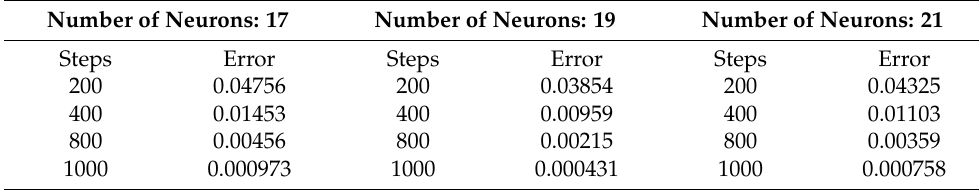
Table 4. Error convergence of different neurons in hidden layers. Number of Neurons: 17